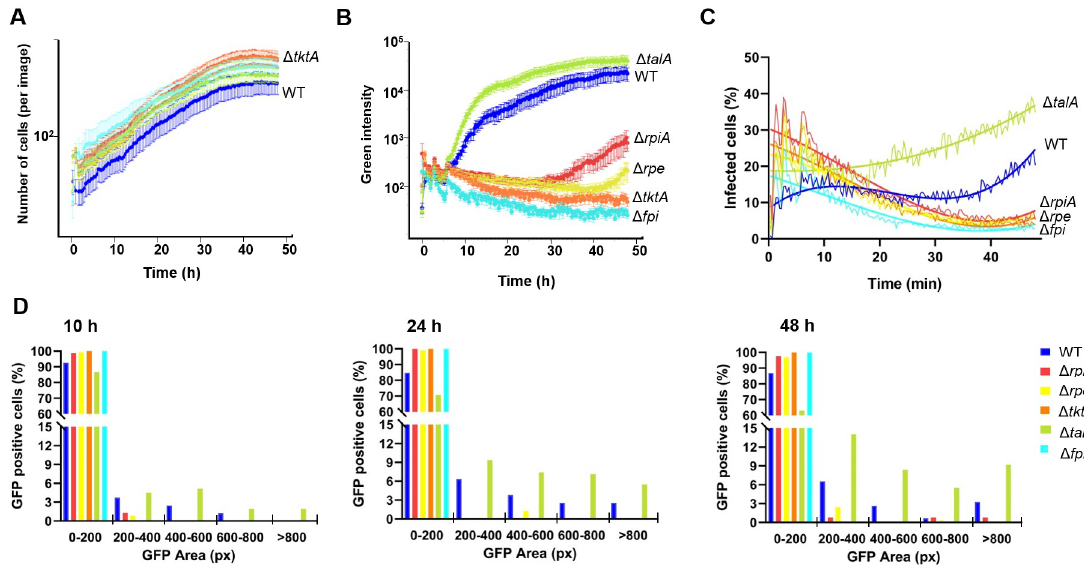
Fig 5. Time lapse video microscopy analyses of the PPP mutants. J774.1 red cells (expressing mKate2 nuclear-restricted red fluorescent protein) were infected with bacteria expressing the green fluorescent protein (GFP), in DMEM supplemented with glucose (MOI = 100). One hour after infection, cells were washed several times with gentamicin-containing medium (10 μ g mL -1 ) to remove extracellular bacteria. A gentamicin concentration of 10 μ g mL -1 was then maintained throughout the experiment. Images were acquired every 20 min using the IncuCyte S3 live cell imaging system (Essen BioScience) over a 48-h period. The kinetics of intracellular multiplication of PPP mutants were monitored by Incucyte S3 software (Incucyte Live-Cell Analysis System, Sartorius). F . novicida WT is shown in blue; the negative control strain Δ fpi , in cyan; Δ rpiA , in red; Δ rpe in yellow; Δ tktA , in orange; and Δ talA , in green. ( A ) Total number of J774.1 red cells was determined by counting the number of red nuclei per image every 20 minutes. An image taken 1h post-infection generally contains between 50 and 100 cells. Results are presented as the mean and standard deviation of sixteen images. ( B ) Bacterial multiplication (GFP-expressing bacteria) was monitored by checking the total area of green particles ( i . e ., GFP-expressing bacteria) in each image (containing between 50 and 250 cells) every 20 min. Multiplication was translated into graphical lines using the Incucyte S3 software. Results are presented as the mean and standard deviation of sixteen images. ( C ) The total number of GFP-positive cells ( i . e ., infected with GFP-expressing bacteria) was monitored by quantifying the percentage of cells with red nuclei associated with at least one detectable green intensity signal in one image (containing between 50 and 250 cells). Results are presented as the mean and interpolation curve of eight images. ( D ) At selected times (10 h, 24 h, and 48 h), the number of GFP-positive cells was decomposed into 5 categories based on the area of the detected GFP signal (in pixels; px): i) 0–200; px ii) 200–400; px, iii) 400–600; px; iv) 600–800; and > 800; px; and corresponding to increasingly infected cells. The data presented correspond to the total number of cells in 8 images.